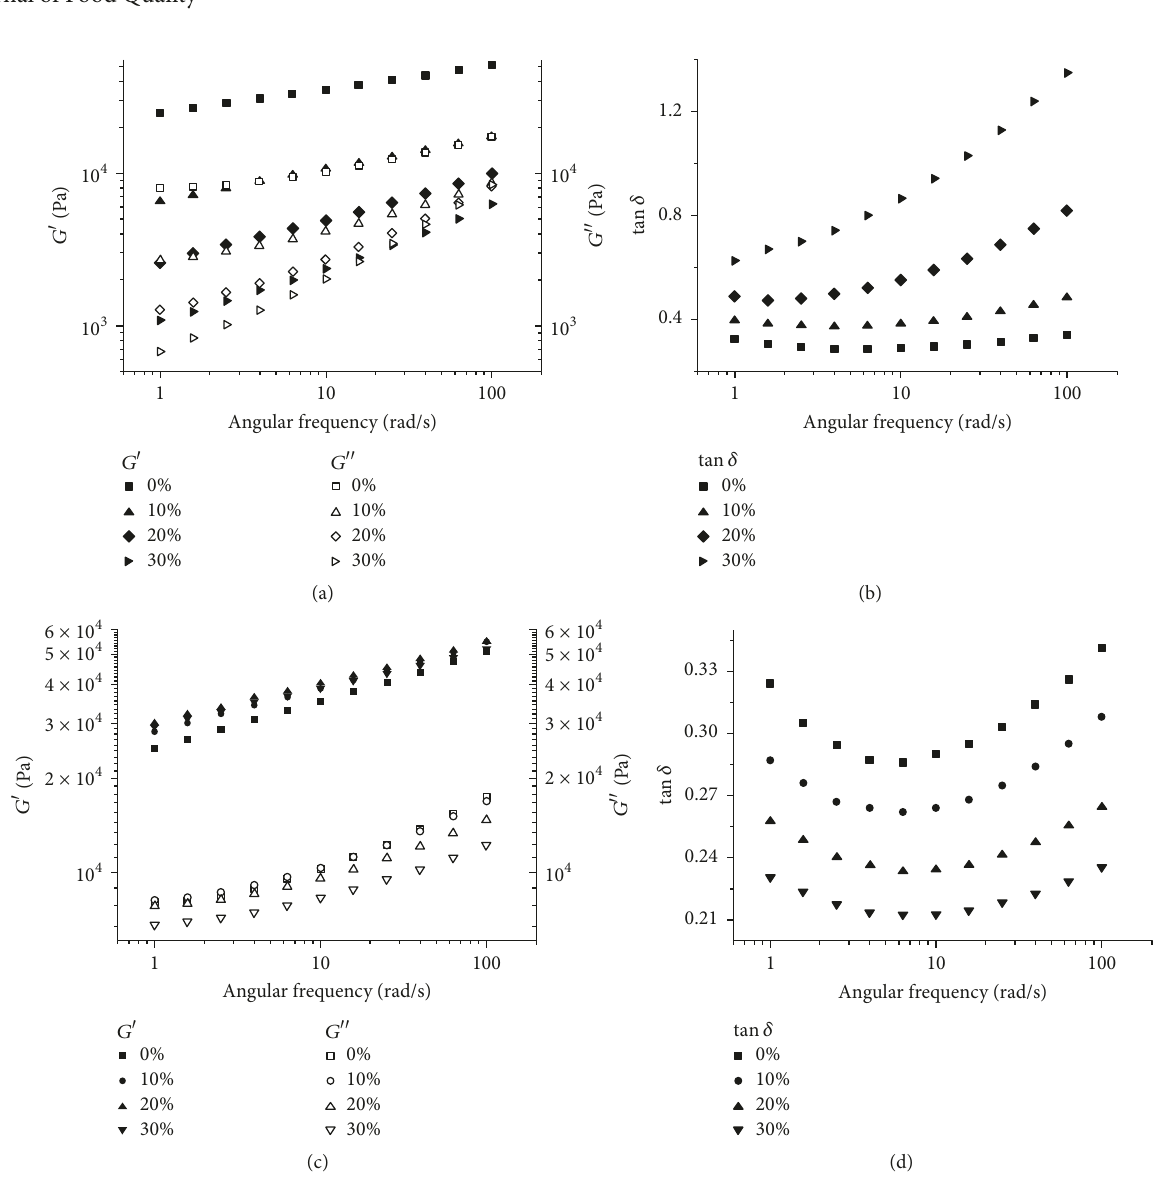
observed. For wheat dough, the first stage was observed from 30 ∘ C to 54 ∘ C. As the temperature increased, the values of 𝐺 󸀠 and 𝐺 󸀠󸀠 decreased slightly, possibly due to hydrolysis of damaged starch by amylase. The second stage was observed at temperatures above 54 ∘ C. At this stage, 𝐺 󸀠 increased rapidly and reached a maximum value at 72 ∘ C, indicating the gela- tinization of starch. During gelatinization, amylose chains leached out into the aqueous intergranular phase, increasing dough viscosity and elasticity [24]. At the third stage, starch gelatinization was complete and 𝐺 󸀠 and 𝐺 󸀠󸀠 began to decrease because of starch degradation. Upon the addition of WP, the transition temperature and the temperature at which the maximum value of 𝐺 󸀠 and 𝐺 󸀠󸀠 was observed were clearly delayed and dependent on the amount of WP added. The increase in transition temperature was consistent with the